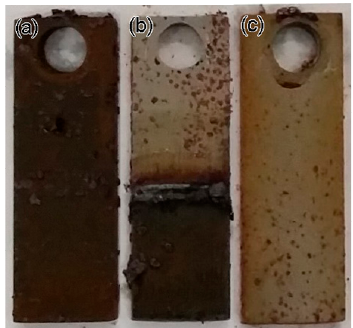
Figure 7. Morphology of specimens after corrosion test: ( a ) full immersion, ( b ) half immersion and ( c ) high-pressure gas exposure.